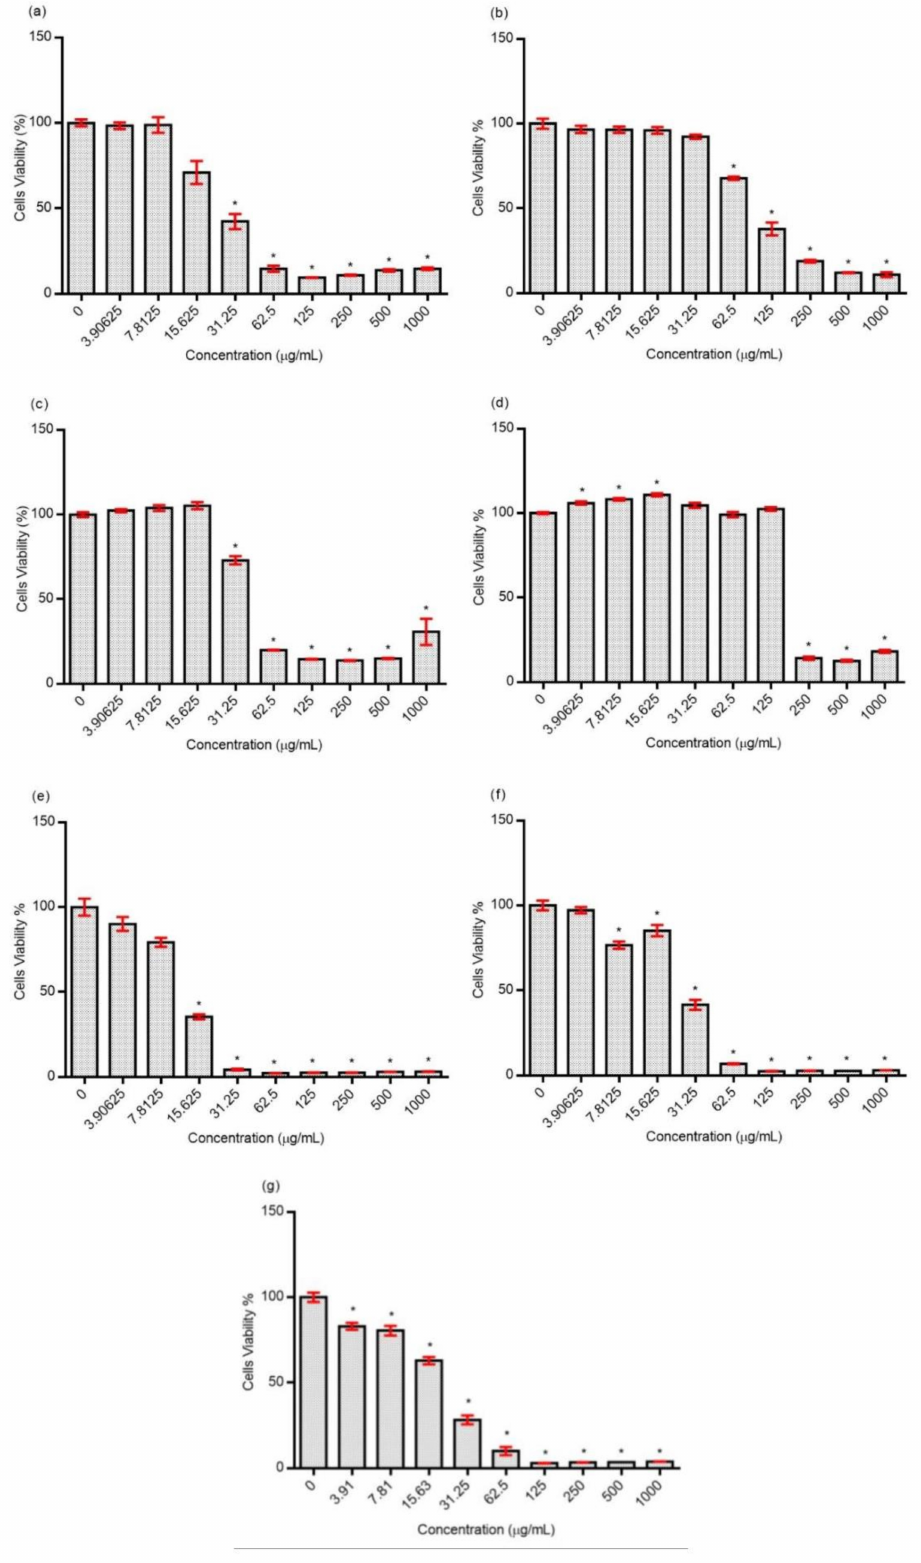
Figure 8. Antiproliferative effect of OS and its fractions on DU145 cell line after 24 h of treatment. ( a ) Crude extract, ( b ) F1, ( c ) F2, ( d ), F3, ( e ) F4, ( f ) F5, and ( g ) F6. The data represent the mean ± SD of three experiments. * represents significant results ( p < 0.05) compared with control (untreated DU145